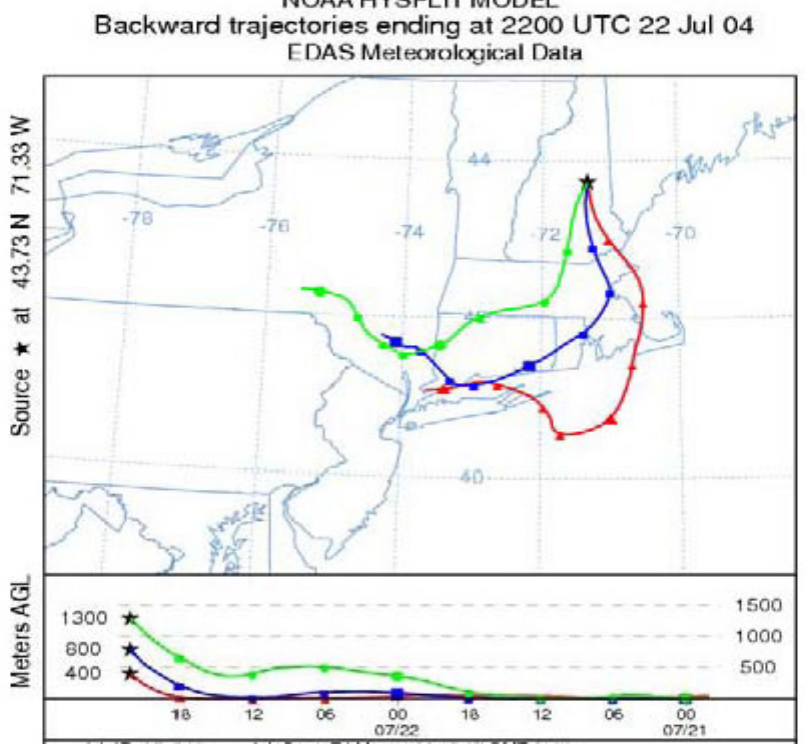
Figure 17. Forty-eight hours backward trajectories from NOAA HYSPLIT model starting at CS. The starting altitude 400 m is in red, 800 m in blue, and 1300 m in green